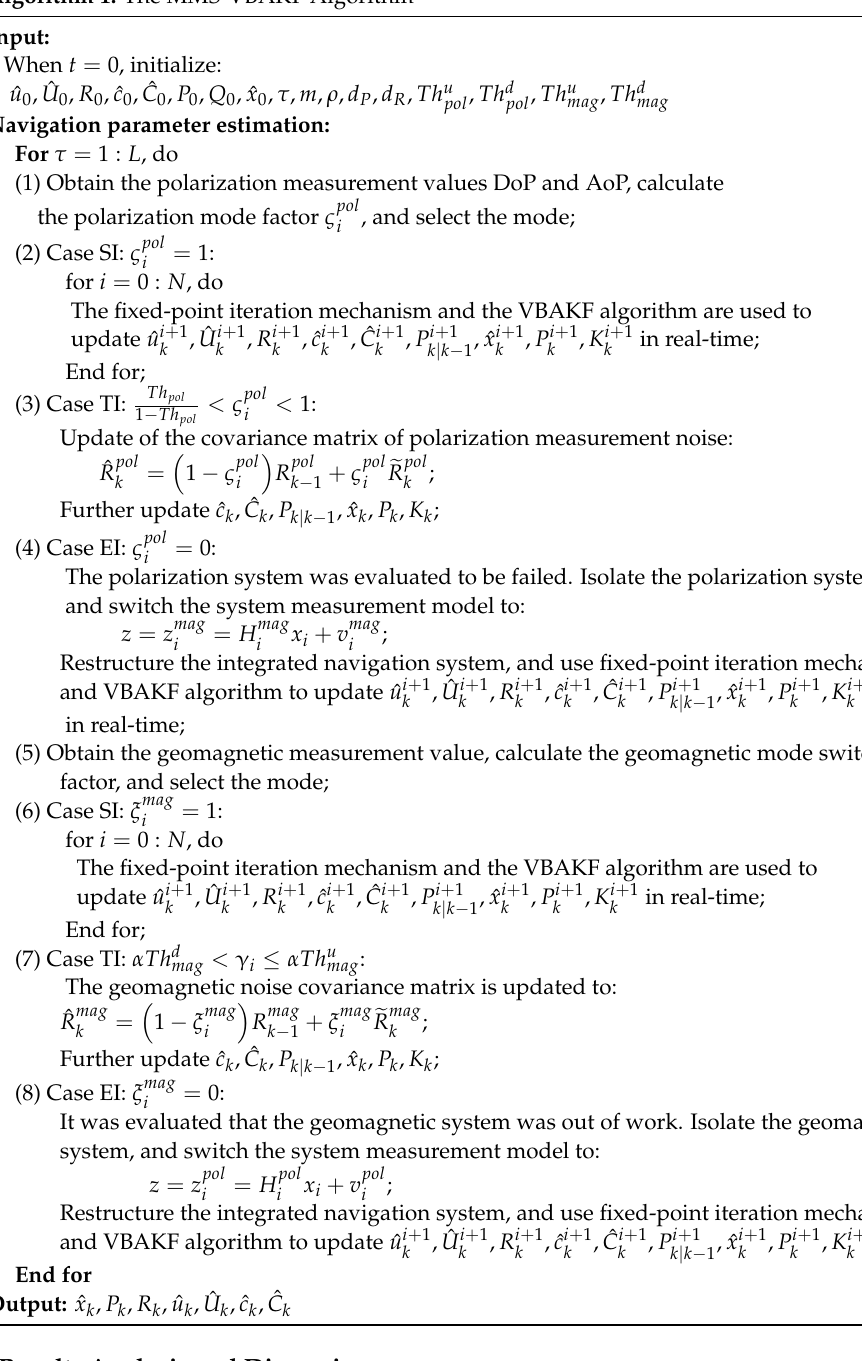
Algorithm 1: The MMS-VBAKF